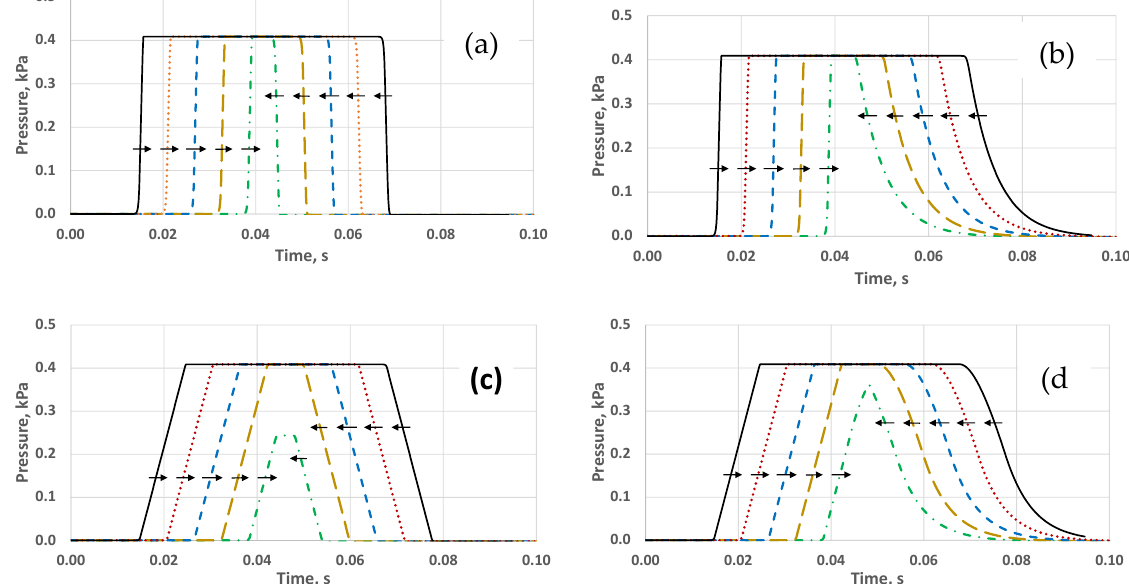
Figure 9. Pressures at successive locations as a wavefront approaches and reflects from a reservoir. ( a ) Steep ramp, assuming instantaneous reflections. ( b ) Steep ramp, allowing for true reflection delays. ( c ) More gentle ramp, assuming instantaneous reflections. ( d ) More gentle ramp, allowing for true reflection delays. (The arrows indicate the direction of travel of the wavefronts along the duct as they pass the locations at which the graphs are drawn)